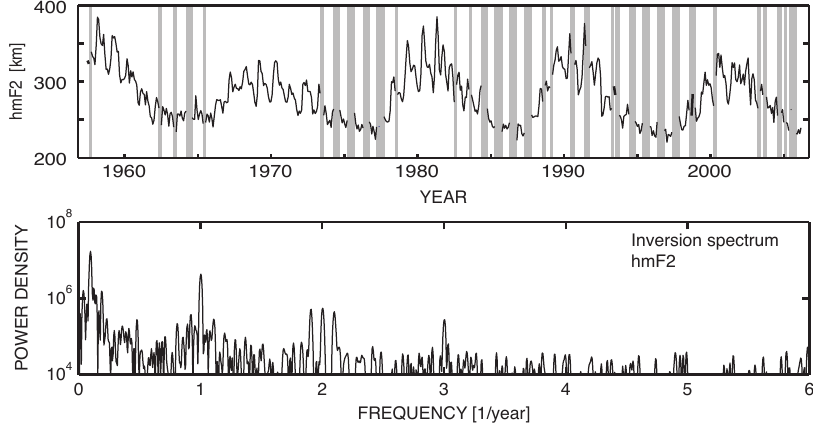
Fig. 9. Same as Fig. 7 for the F-layer maximum altitude hm F2. There are even more gaps in the data than in Fig. 8.